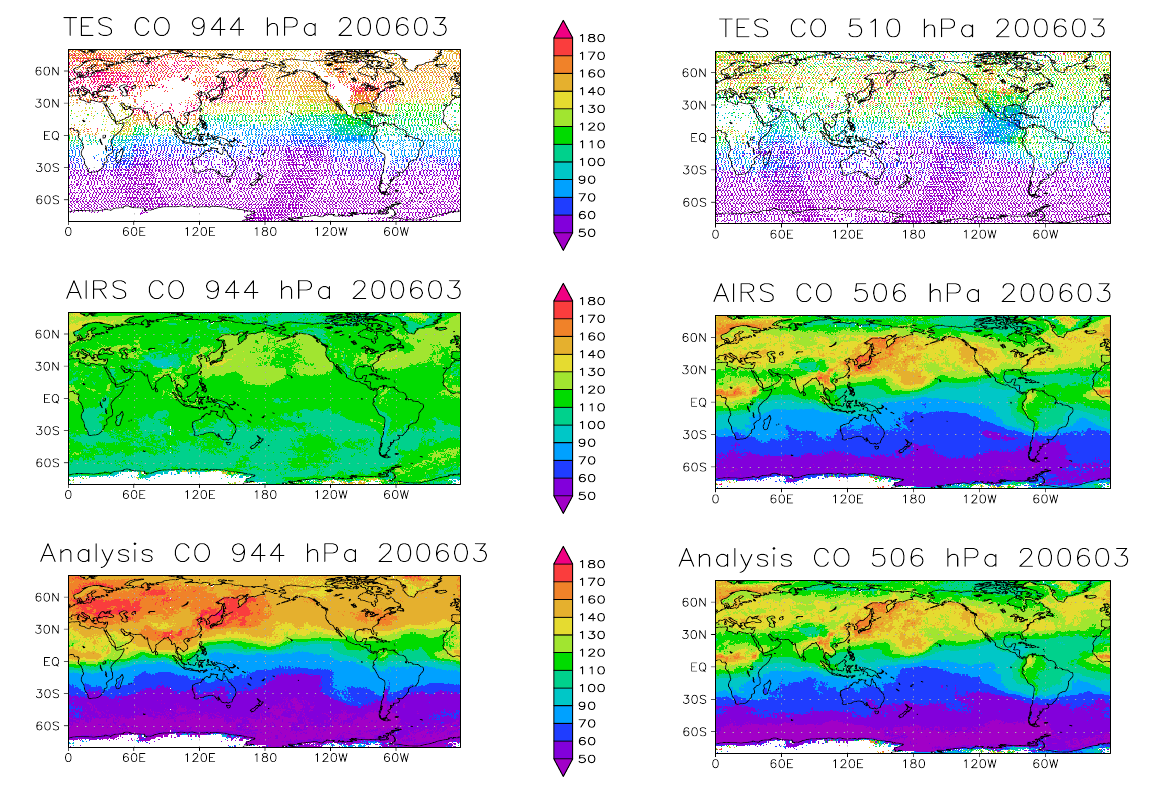
Fig. 7. As Fig. 6 except at 506 hPa.